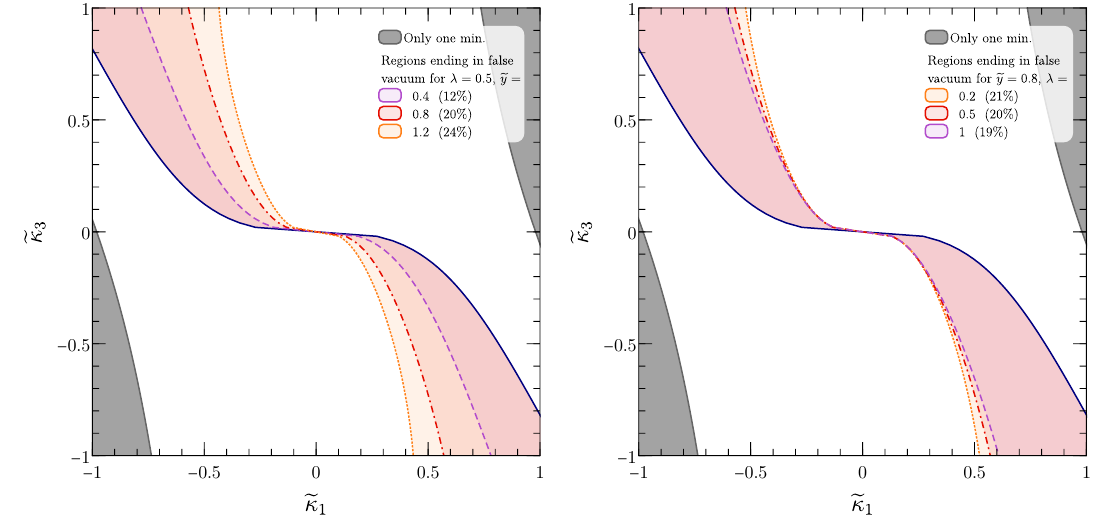
Figure 7 . Similarly to (cid:12)gure 6, we show the regions where (cid:30) ends up in its false vacuum after the thermal phase (i.e. the equivalent of the orange regions in (cid:12)gure 6) for di(cid:11)erent values of and (cid:21) (cid:24) 0 : 1 (cid:0) 1. Across the ranges shown in these plots, the shaded regions cover about 10% to 20% of parameter space. This implies a modest amount of tuning in parameter space needed to realise the mechanism shown in (cid:12)gures 1 and 3, so that the axion (cid:12)eld has an initial misalignment close to (cid:25)